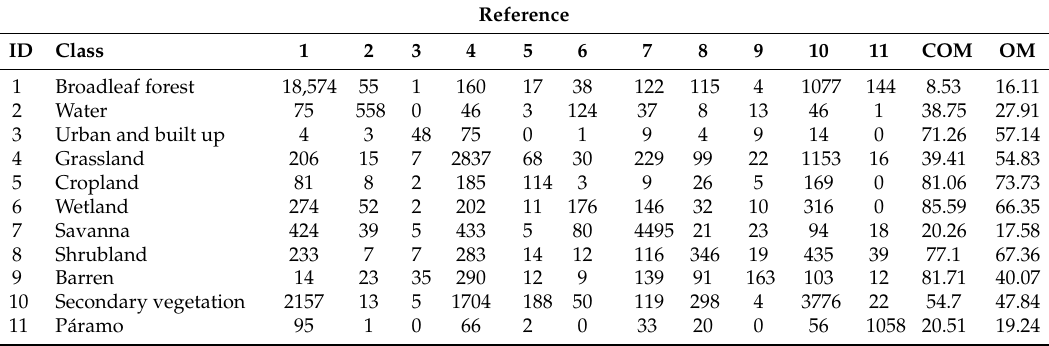
Table 7. Confusion matrix for land cover classification of multi-year data integration for 2011 (cid:8) 2 years and adding elevation (TS-F-C2-E). Overall accuracy is 70.5%, Kappa coefficient is 0.59. Commission (Com) and omission (Om) errors (%) are listed for each